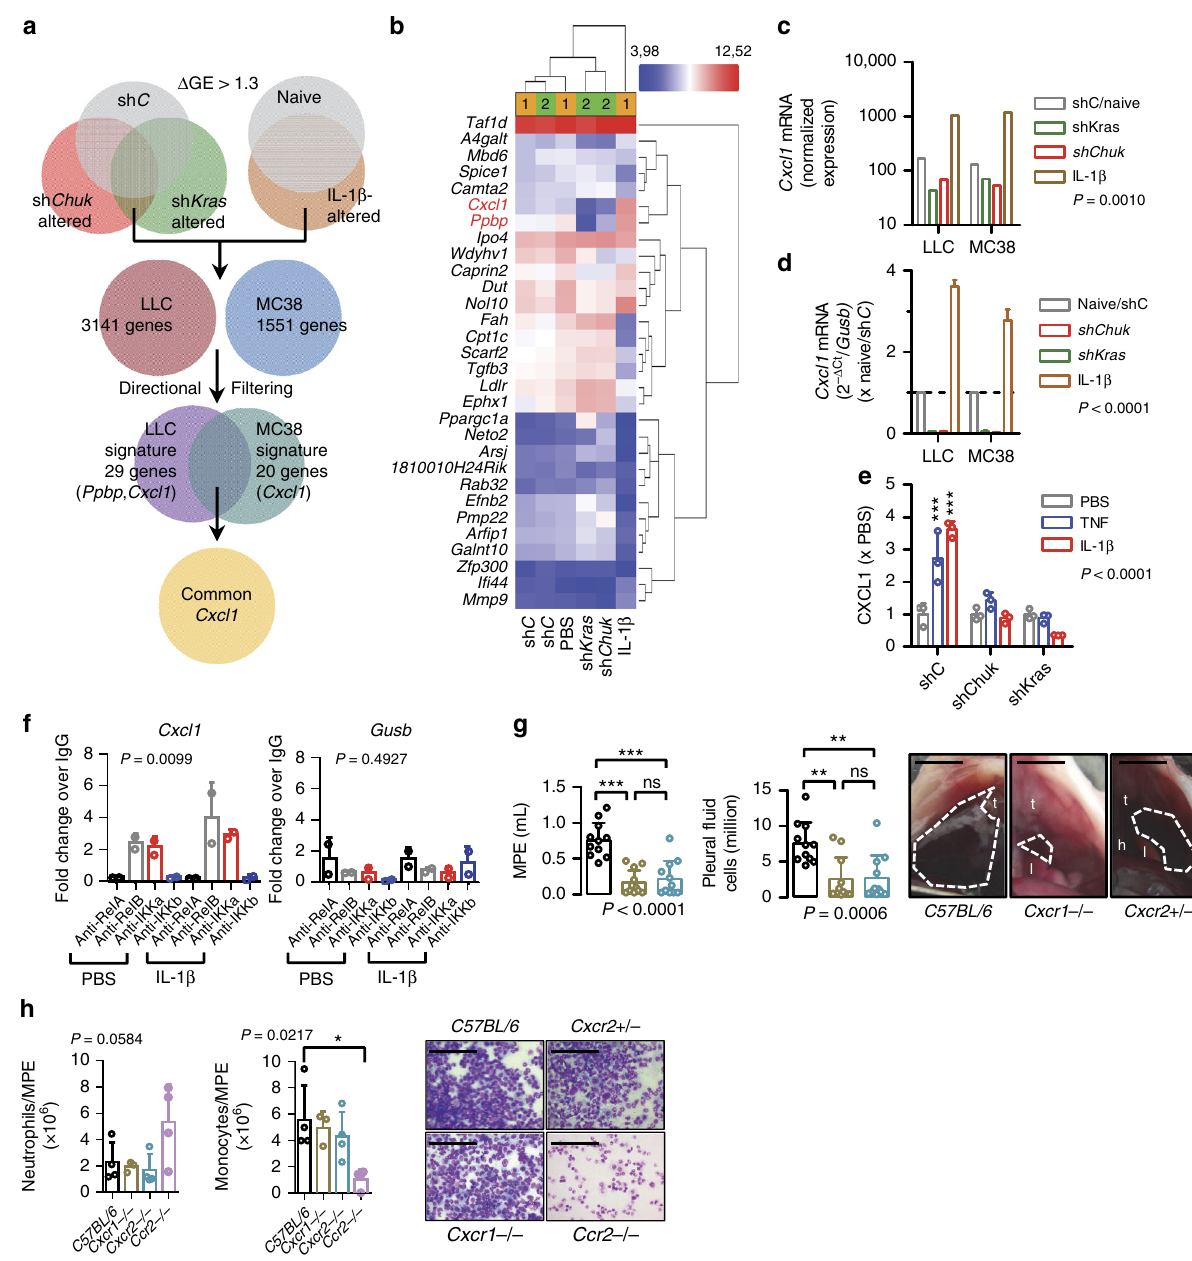
Fig. 8 CXCL1/PPBP are the downstream effectors of KRAS/IL-1 β /IKK α signaling in malignant pleural effusion. a – c LLC and MC38 cells were stably transfected with sh C or sh Kras or shChuk or were stimulated with 1 nM IL-1 β for 4 h, and total cellular RNA was examined by Affymetrix mouse gene ST2.0 microarrays. a Venn diagram of analytic strategy employed: transcripts altered > 1.3-fold in one direction by sh Kras and sh Chuk and in the other by IL-1 β were fi ltered for each cell line and are given in Supplementary Tables S1 – S2. These gene sets, coined KRAS/IL-1 β /IKK α signatures, were crossexamined and only Cxcl1 was common to both. b Unsupervised hierarchical clustering of LLC cell results by the 29-gene KRAS/IL-1 β /IKK α signature accurately clustered three control samples together, sh Kras and sh Chuk samples together, and IL-1 β -stimulated cells apart. c Cxcl1 mRNA normalized expression levels by microarray ( n = 2 independent experiments). d Cxcl1 mRNA expression by qPCR relative to Gusb ( n = 3 independent experiments). e CXCL1 protein secretion by LLC cells stably expressing sh C , sh Chuk , or sh Kras after 24 h of stimulation with PBS or 1 nM TNF or IL-1 β ( n = 3 independent experiments). f